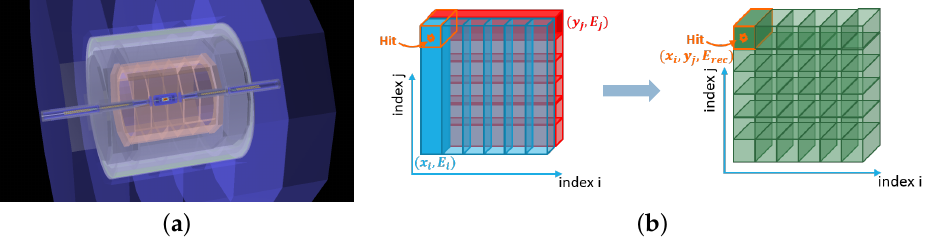
Figure 2. The CEPC CDR detector layout (“CEPCv4”) for PFA performance studies with implemen- tations of the SiW-ECAL (as the CDR baseline) and crystal ECAL in two scenarios. ( a ) CEPC CDR baseline detector. ( b ) Reconstruction with long crystal bars with an aim of fine transverse